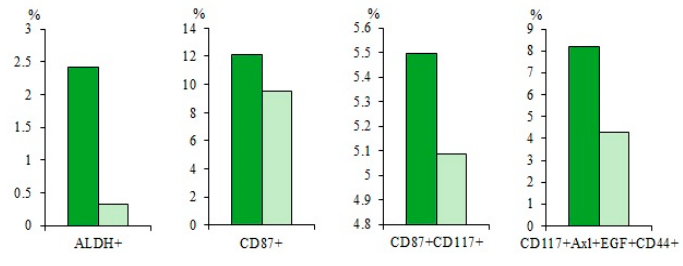
After chemotherapy there was a decrease in the number of CTCs with phenotypes ALDH + (by 86.3%), CD117 + Axl + EGF + CD44 + (by 48%), CD117 + EGF + (by 48%), and EGF + Axl + (by 41%) in the blood of patient G relative to same indicators before treatment (Figure 11). Changes in the content of CTCs expressing CD87 and CD276 were not significant.